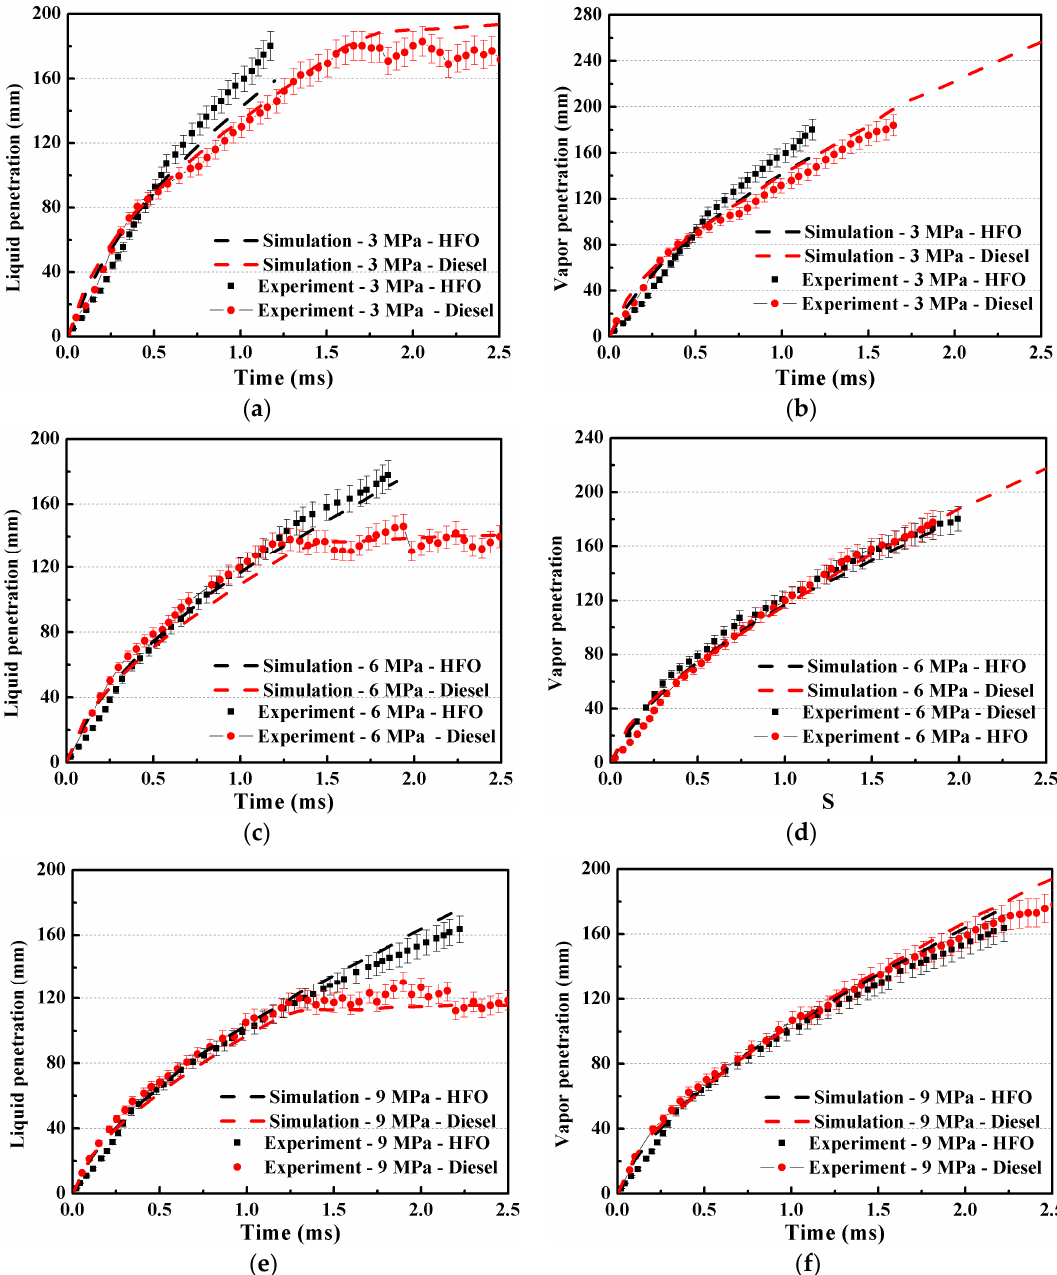
Figure 3. Comparison of liquid and vapor spray penetrations obtained by simulation and experiment for HFO and diesel under different ambient pressures. ( a ) Liquid phase penetration at 3 MPa of ambient pressure; ( b ) Vapor phase penetration at 3 MPa of ambient pressure; ( c ) Liquid phase penetration at 6 MPa of ambient pressure; ( d ) Vapor phase penetration at 6 MPa of ambient pressure; ( e ) Liquid phase penetration at 9 MPa of ambient pressure; ( f ) Vapor phase penetration at 9 MPa of ambient pressure.